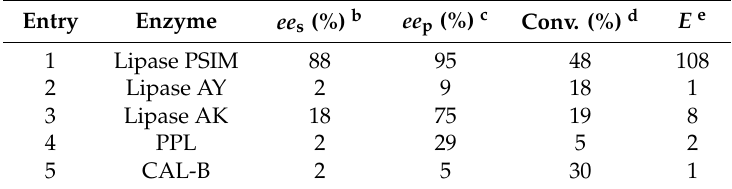
Table 2. Enzyme screening in the hydrolysis of ( ± )-3 a a .